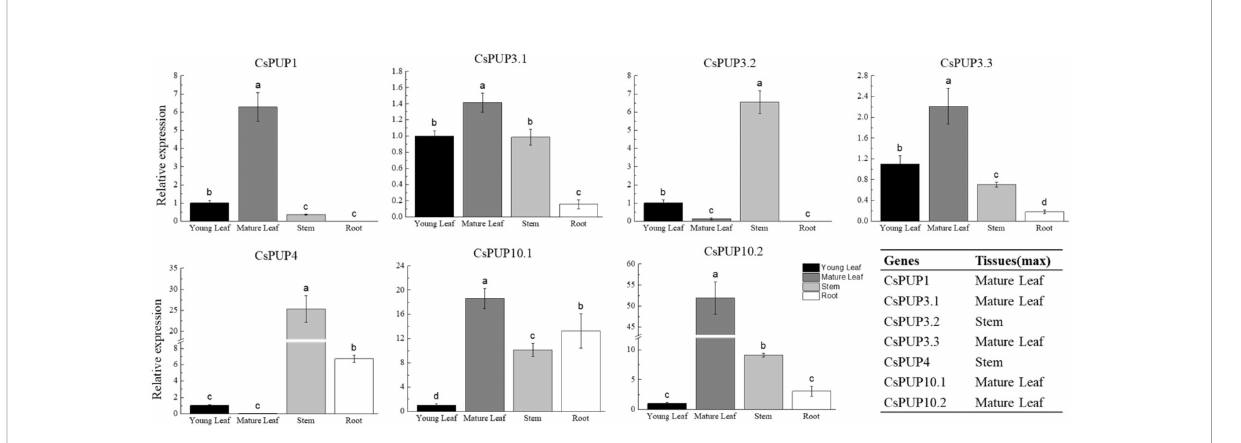
FIGURE 4 Expression patterns of CsPUPs in different